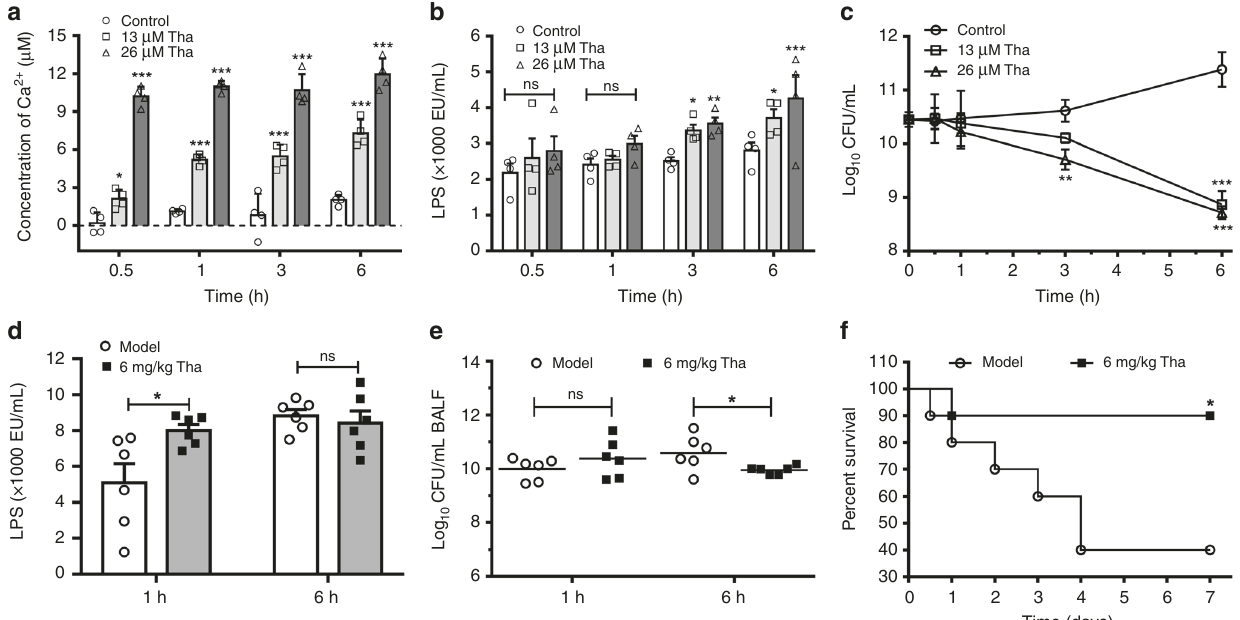
Fig. 2 Thanatin promotes the release of Ca 2 + and LPS from the OM. a – c Release of Ca 2 + ( a ) and LPS ( b ) from thanatin-treated E. coli XJ141026 (3 × 10 10 CFU/mL) was detected, and time-kill curves were monitored ( c ). d , e LPS levels ( d ) and bacterial loads ( e ) in the BALF of E. coli XJ141026-infected pneumonia mice were analyzed at 1 and 6 h after 6 mg/kg thanatin treatment ( n = 6 per group). f Survival curves for the E. coli XJ141026 pneumonia model. BALB/c mice were intranasally infected with a sublethal dose of E. coli XJ141026 and treated with 6 mg/kg thanatin via intraperitoneal injection ( n = 10 per group). All data are shown as the mean ± s.e.m. from at least three independent experiments. P- values were determined by two-way ANOVA ( a – c ), two-tailed unpaired t -test ( d , e ) or log-rank test ( f ). ns means not signi fi cant; * P < 0.05, ** P < 0.01, ** *P < 0.001 vs. control or model. Source data are